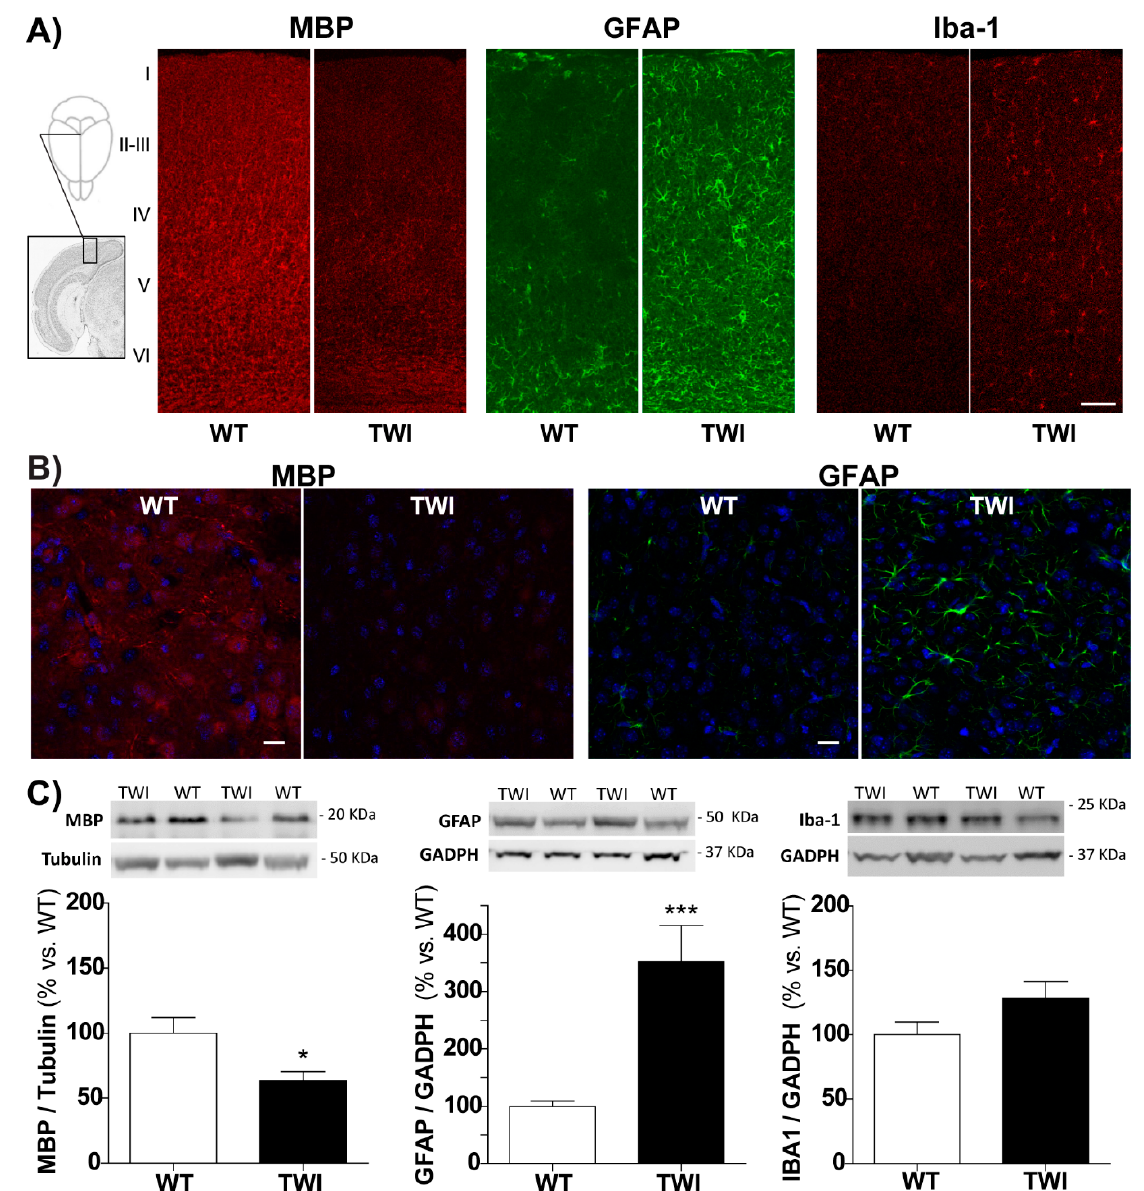
Figure 2. ( A ) Coronal sections through the visual cortex (inset) of representative WT (left) and TWI (right) mice (PND34) immunostained with antibodies against myelin basic protein (MBP) (marker of myelination), glial-fibrillary acidic protein (GFAP) (marker of astrogliosis), and Iba-1 (Ionized calcium-binding adaptor molecule 1, marker of microglia/macrophages). Cortical layers are indicated by Roman numbers on the left. Notice reduced myelin staining and robust gliosis in the visual cortex of TWI mice. Scale bars = 100 μ m. ( B ) Representative confocal images of WT (left) and TWI (right) mouse brain (i.e., motor cortex) immunostained for MBP (marker of myelination, in red) and GFAP (marker of astrogliosis, in green), together with nuclei (DAPI, in blue): the overall degeneration status is comparable with the one of visual cortex. Scale bars = 20 μ m. ( C ) Representative Western blot panels and blot analysis of MBP, GFAP, and Iba-1 levels in brain tissue lysates from WT (white) and TWI (black columns) mice. Results (normalized to Tubulin or GAPDH, Glyceraldehyde-3-phosphate Dehydrogenase, levels) were reported in % with respect to WT levels. */*** p < 0.05/0.001 WT vs. TWI; Student’s t -test. Data= mean ± SEM, n ≥ 18; WT mice: age range PND29-43; TWI mice: age range PND30-40.